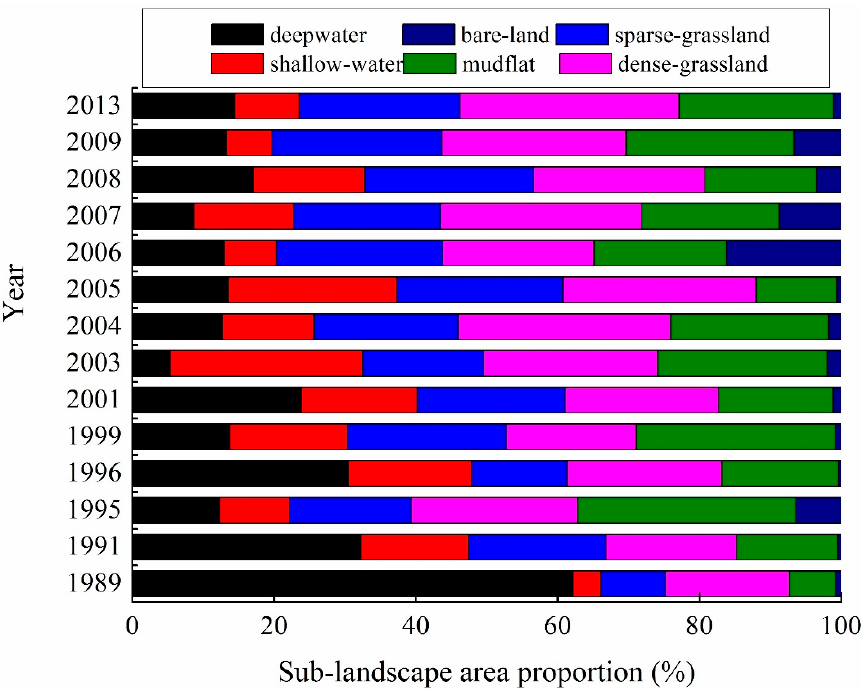
Figure 3. The area proportion of the 6 landscape at the Poyang Lake wetland during 1989–2013.